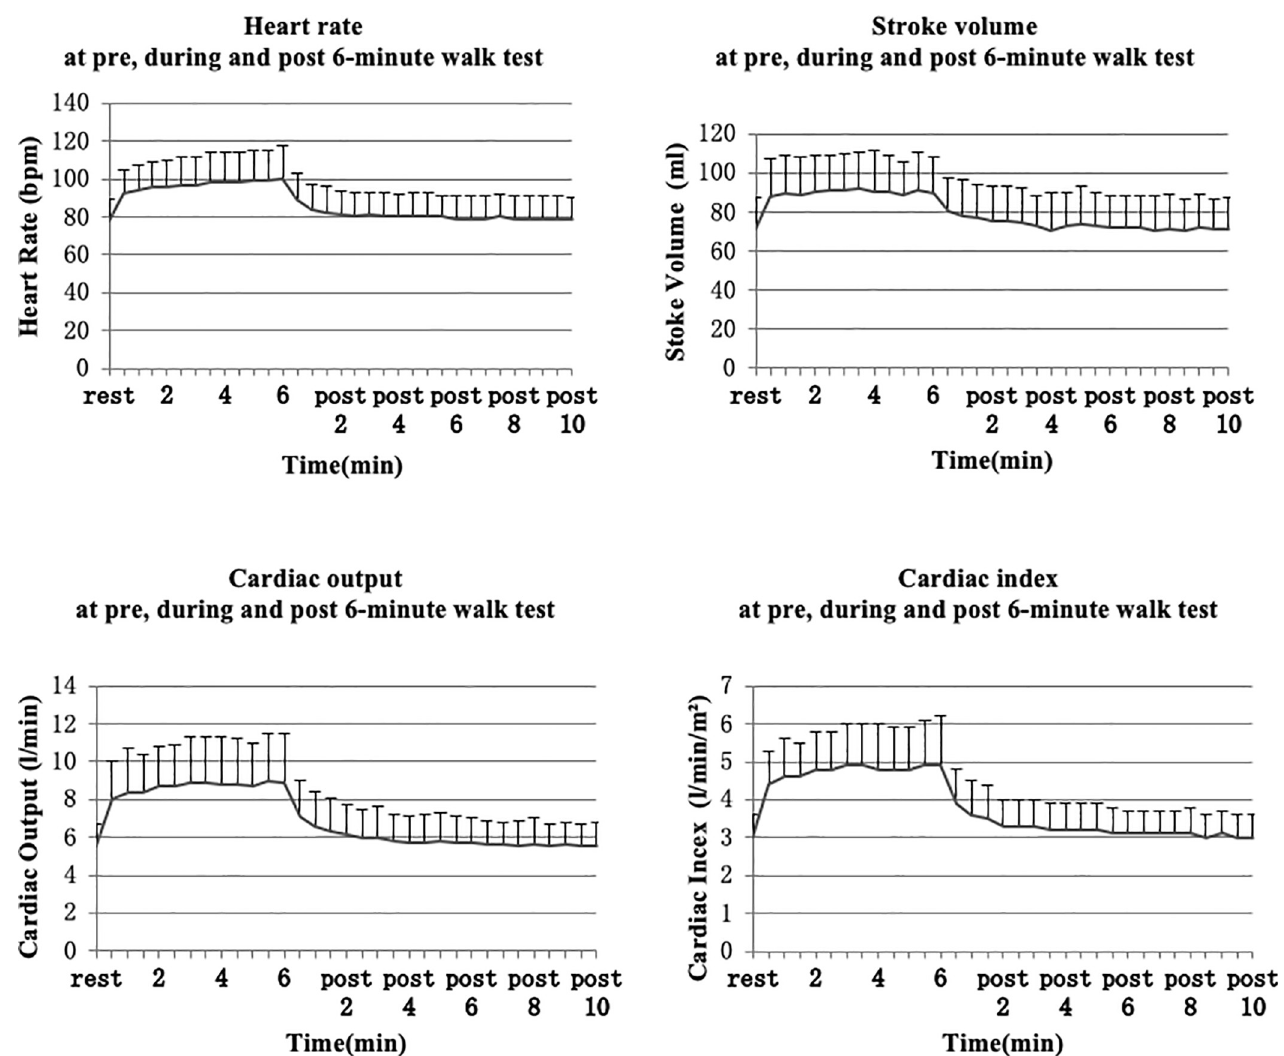
Fig 2. Cardiodynamic changes at rest, during and post